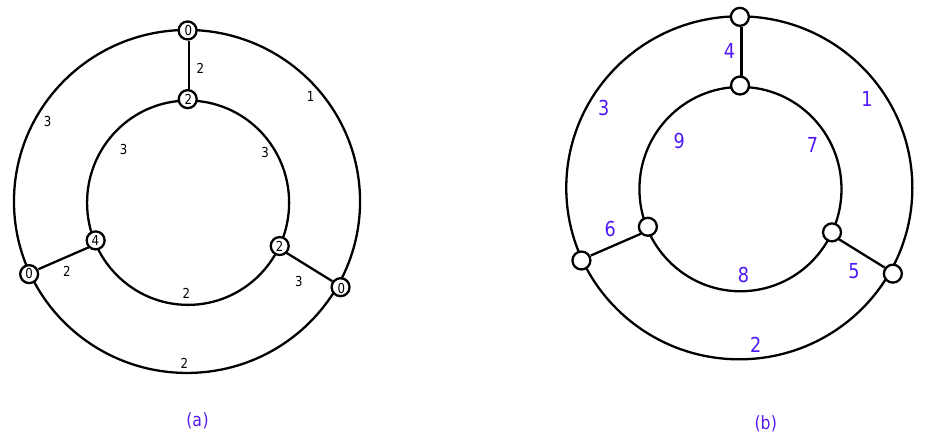
Figure 2. ( a ) A reflexive irregular 4-labeling for D 1